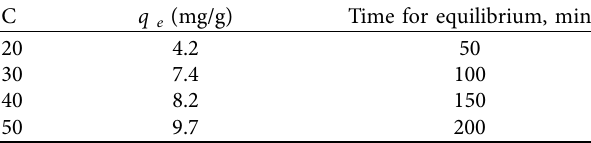
Table 3: Influence of contact time on adsorption. Table 4: C